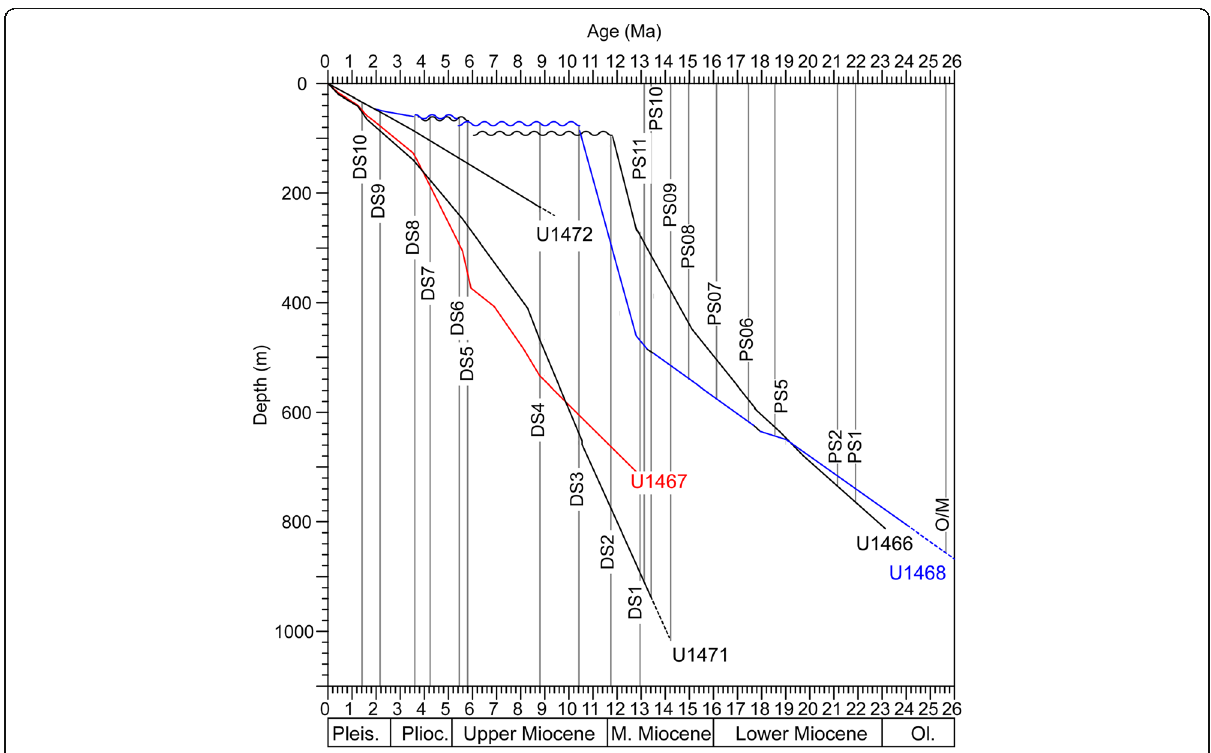
Fig. 7 Age-depth curves for the IODP Expedition 359 sites with age of sequence boundaries. Note that PS3 and PS5 are merged with the